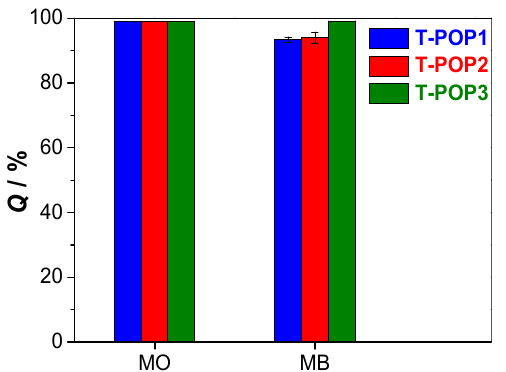
Figure 11. Efficiencies for simultaneous removal of MO and MB by T-POPs, at 25 °C, starting from a solution of nominal concentration of 10 mg L − 1 and real concentration of 7 mg L − 1 (values for each dye).